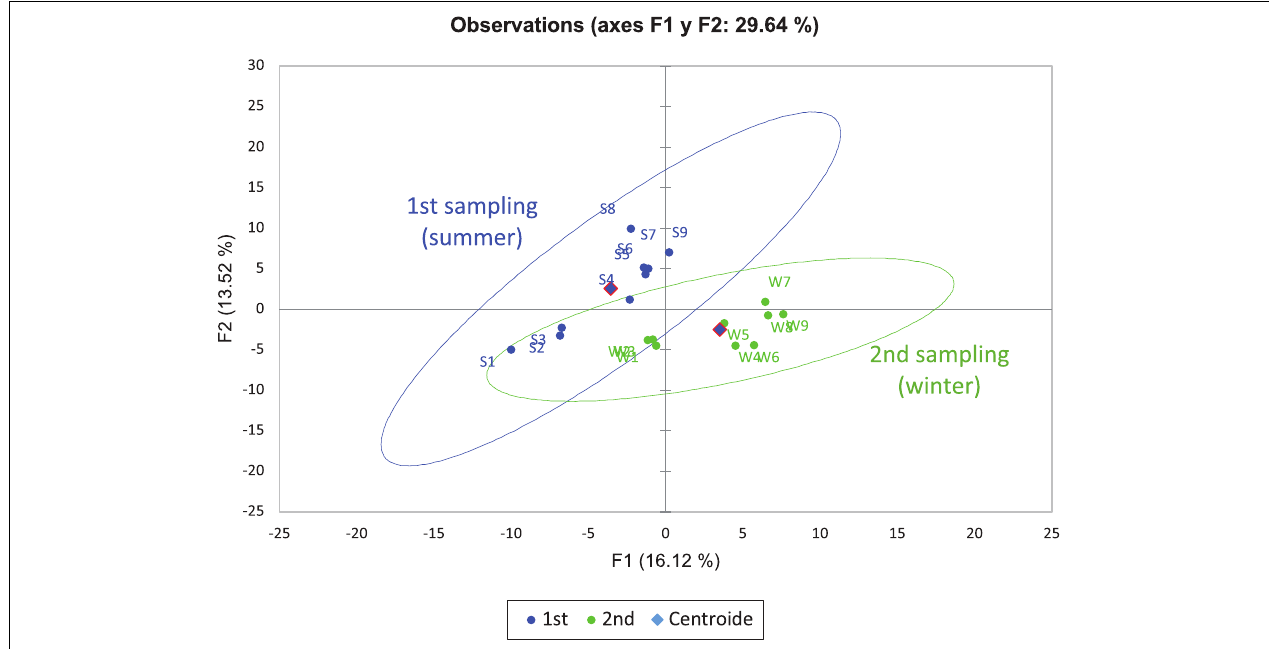
FIGURE 4 | Score plot of PCA with scaled data, representing samples in F1 and F2 axes. Samples corresponding to 1st period (summer) of the study are presented in blue while the samples corresponding to the 2nd campaign (winter) are in green. The two ellipses were generated automatically thus highlighting an area with a 98% probability of containing samples of the same